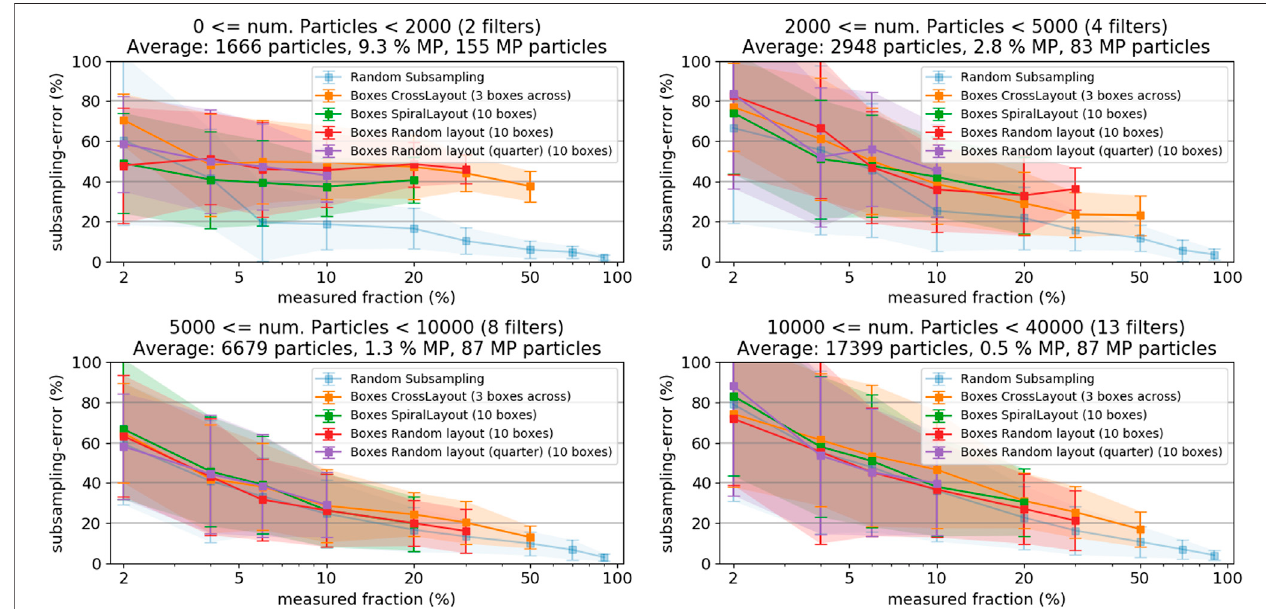
FIGURE9| Subsampling-erroroftheboxplacementmethodsfor fi lterswithlow (A) andhigh (B) particlepatchiness,respectively.Bothplotsalsoshowtherandom particle subsampling method, representing the count error, as reference.